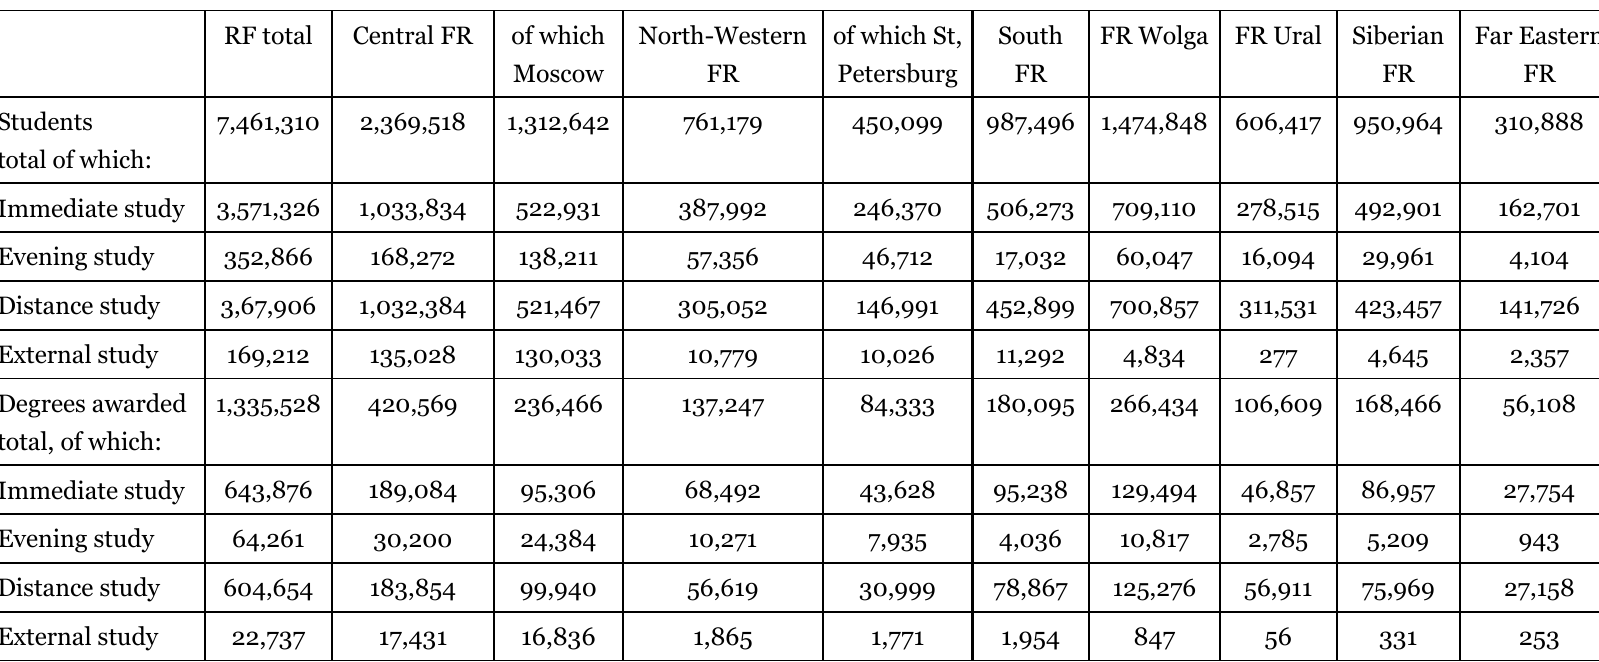
Source: Образование в России – 2007. Статистический бюллетень. – М.: МГУПИ, 2008. [Statistical Report “Education in Russia – 2007”,